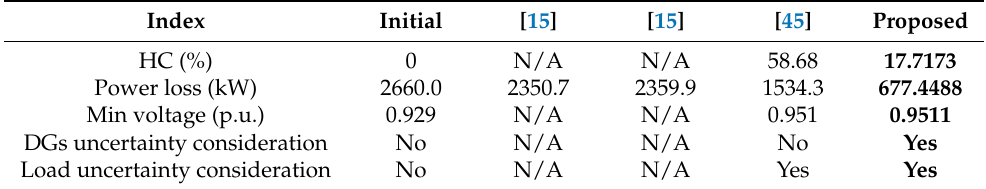
Table 16. A comparison with previous works based on system’s performance indices for the 415-node distribution network.